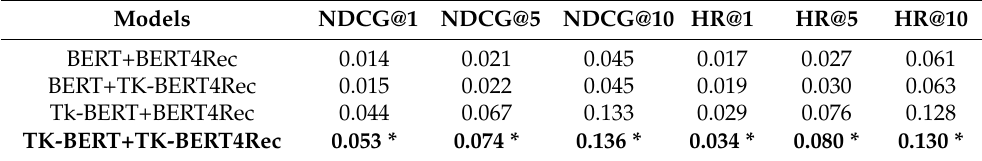
Table 5. Experimental results of ablation experiments using the KdConvRec dataset. Models